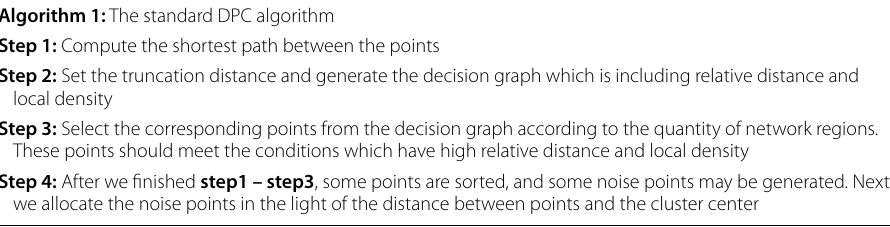
Algorithm 1: The standard DPC